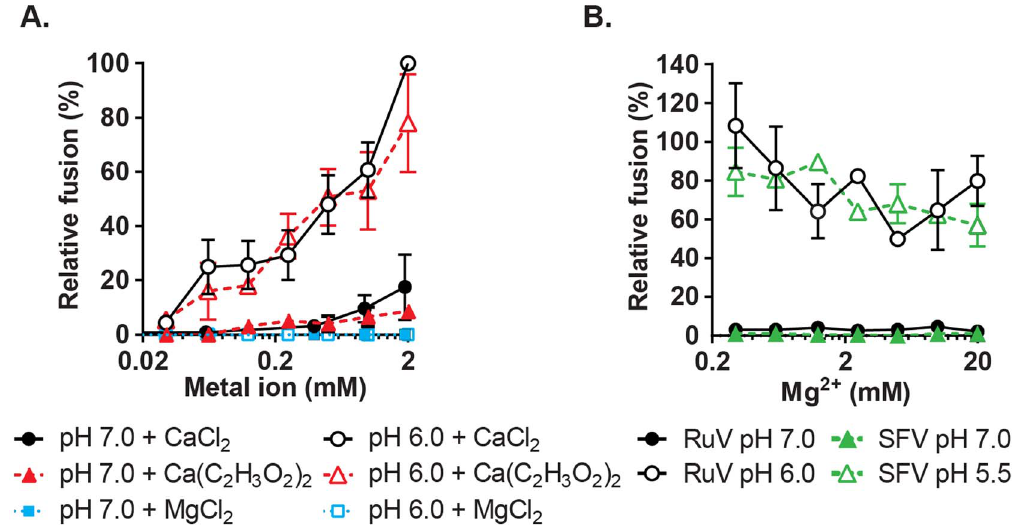
Figure 4. Concentration-dependence and specificity of RuV Ca 2 + requirement. (A) RuV fusion infection assay was performed as in Fig. 3A, in the presence of CaCl 2 , MgCl 2 or Ca(C 2 H 3 O 2 ) 2 buffered with 1 mM EGTA to produce the indicated concentrations of free Ca 2 + or Mg 2 + . Data were normalized to the pH 6.0, 2 mM CaCl 2 sample, and are the mean and standard deviation of 3 independent experiments. (B) RuV and SFV fusion infection assays were performed as in Fig. 3A, with the fusion media supplemented with 0.5 mM CaCl 2 and 0.2–20 mM MgCl 2 . Data were normalized to pH 6.0 with 0.5 mM CaCl 2 and no added MgCl 2 , and represent the mean and range of 2 independent experiments.